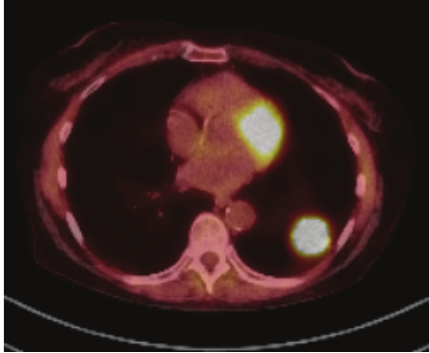
Figure 2: Fused PET/CT axial image shows the left lung